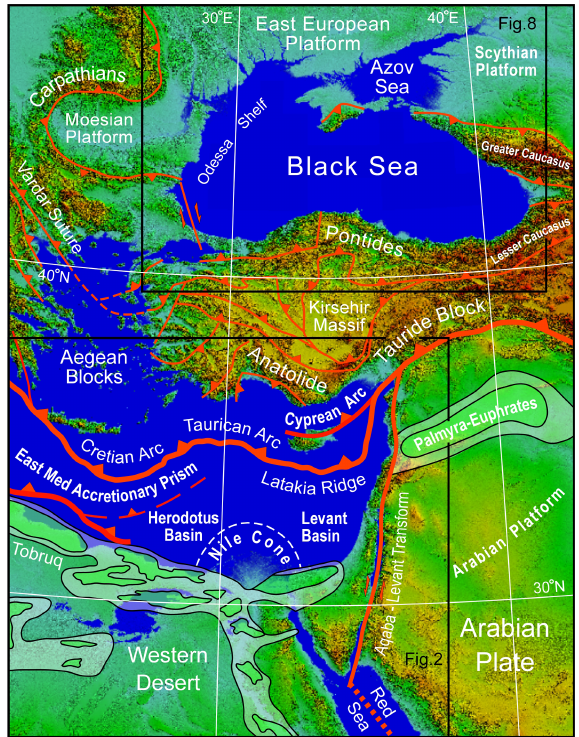
Figure 1. Tectonic setting of the Western Desert (Egypt), eastern Mediterranean and Black Sea. Plate boundaries and major faults are shown in red. Triangles are on upthrown blocks of thrust and reverse faults. Major sedimentary basins of the Western Desert and Arabian plate are shaded in green. Locations of Fig. 2 (eastern part) and Fig. 8 are shown by boxes. Modified from Okay and Tüysüz (1999) and Bosworth et al. (2008) and references therein. Base is SRTM digital elevation model (Jarvis et al., 2008). UTM Zone 36 projec-